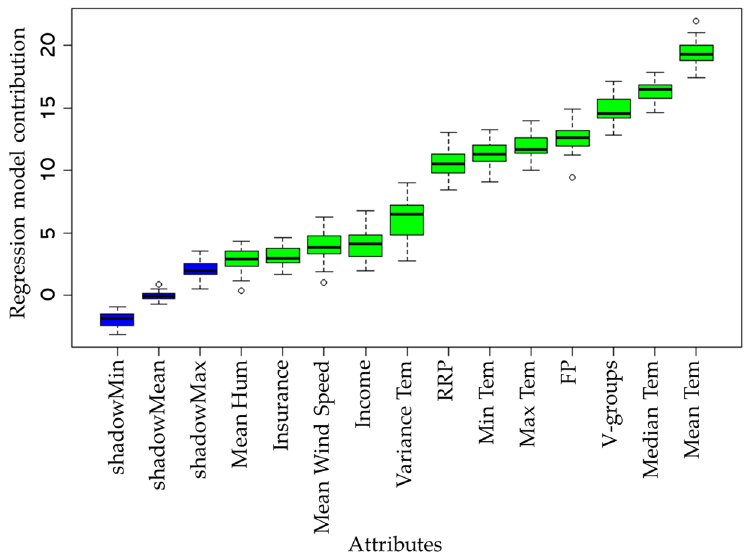
Figure 2. Contribution ranking importance of the 12 independent variables in the random forest (RF)-based variable reduction algorithm from the Boruta package [44] in R.